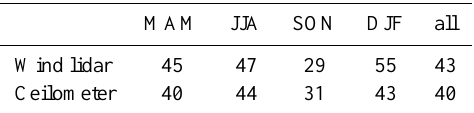
Table 2. Availability (in percent) of MLH retrievals from the wind lidar and ceilometer during the four seasons from December 2011 to November